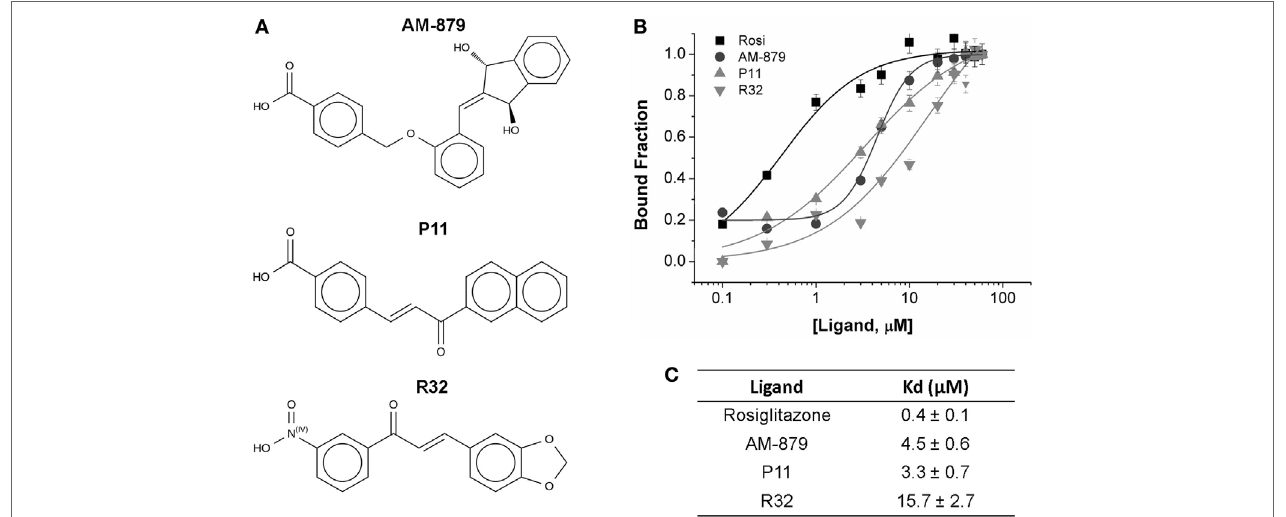
FigUre 2 | Binding affinity of AM-879, P11, and R32 ligands to peroxisome proliferator-activated receptor gamma (PPAR γ ) ligand-binding domain (LBD). (a) Molecular structure of the selected ligands. (B) PPAR γ LBD bound to increased concentrations of Rosiglitazone (Rosi), AM-879, P11, and R32 (until 60 µM). Bound fractions were determined from 8-Anilino-1-naphthalenesulfonic acid (ANS) fluorescence signal decayment at 340 nm, as a result of ANS probe displacement from PPAR γ pocket, and normalized from 0 to 1. Data are the mean ± SEM ( n = 3). (c) Dissociation constants (Kd, in µM) calculated from ligand-binding curves fitted through Hill model using